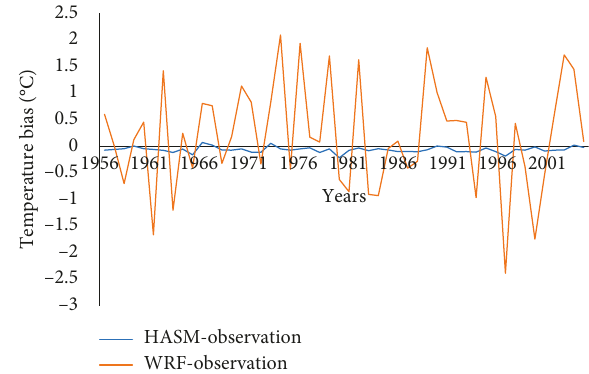
Figure 3: Interannual variability in the average temperature bias of the HASM and WRF data at 26 stations in the Beijing-Tianjin- Hebei region in